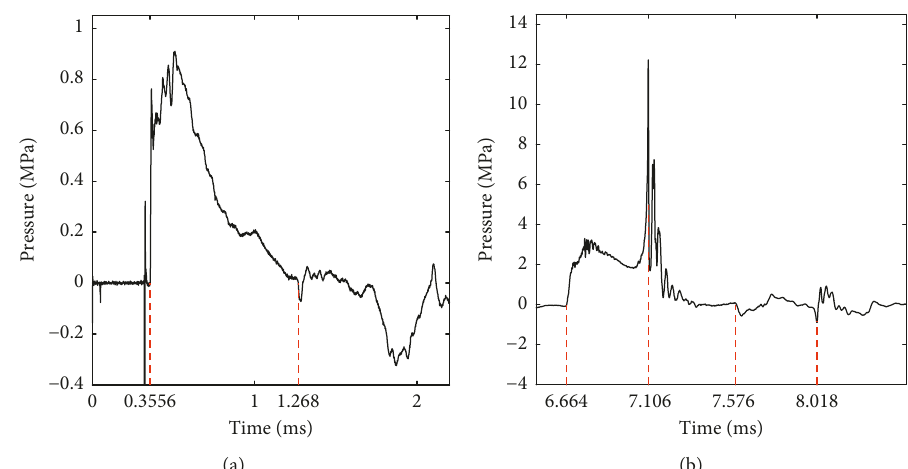
Figure 7: Pressure-time profile recorded by HPB with a 20mm standoff.